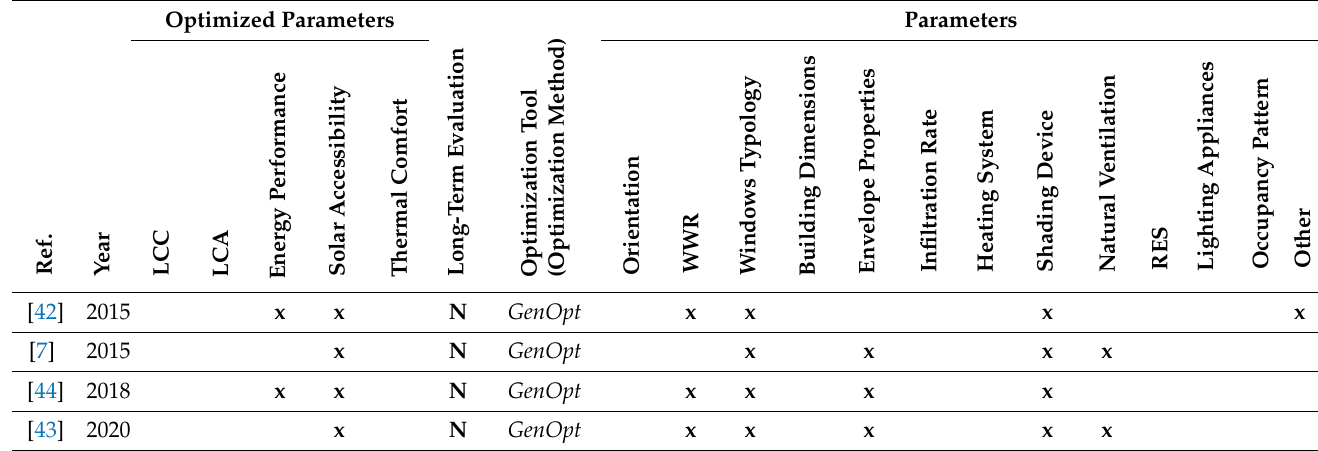
Table 5. Tabular review of journal articles about Java-based MOO